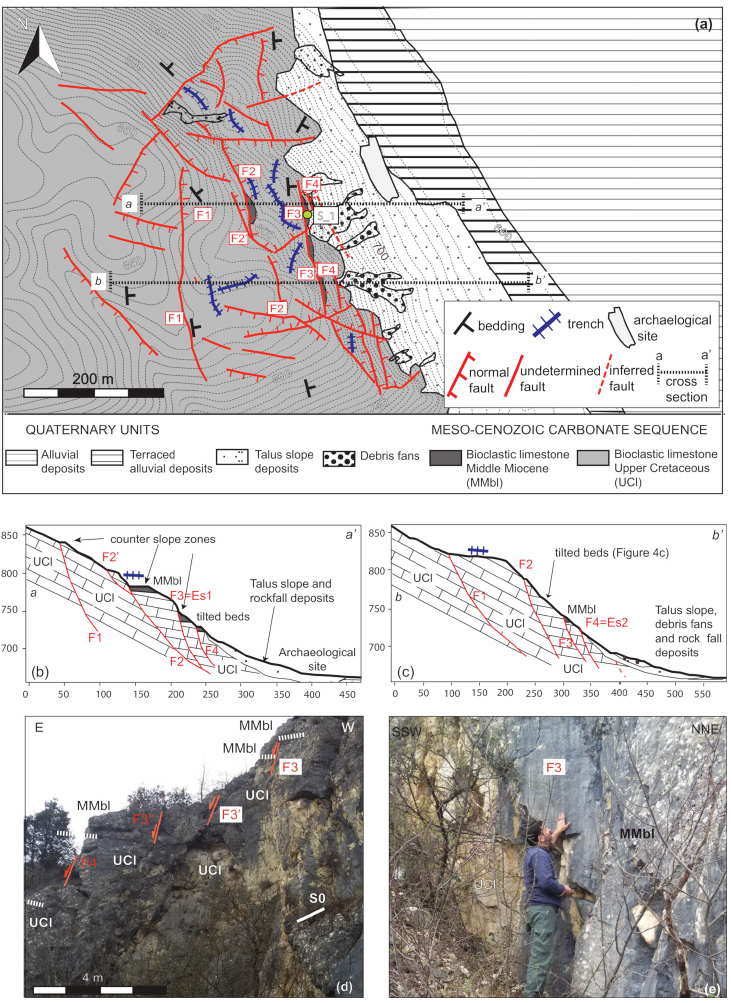
Figure 3. ( a ) Geological map of the study area. Legend: S_1 = geomechanical analysis site; F1-F4 = faults intersecting trace of sections a-a’ and b-b’; ( b ), ( c ) geological sections); ( d ) slope- parallel faults (F3-F4 and secondary splays), UCl = Upper Cretaceous limestone; MMb = Middle Miocene bioclastic limestone; ( e ) particular of fault